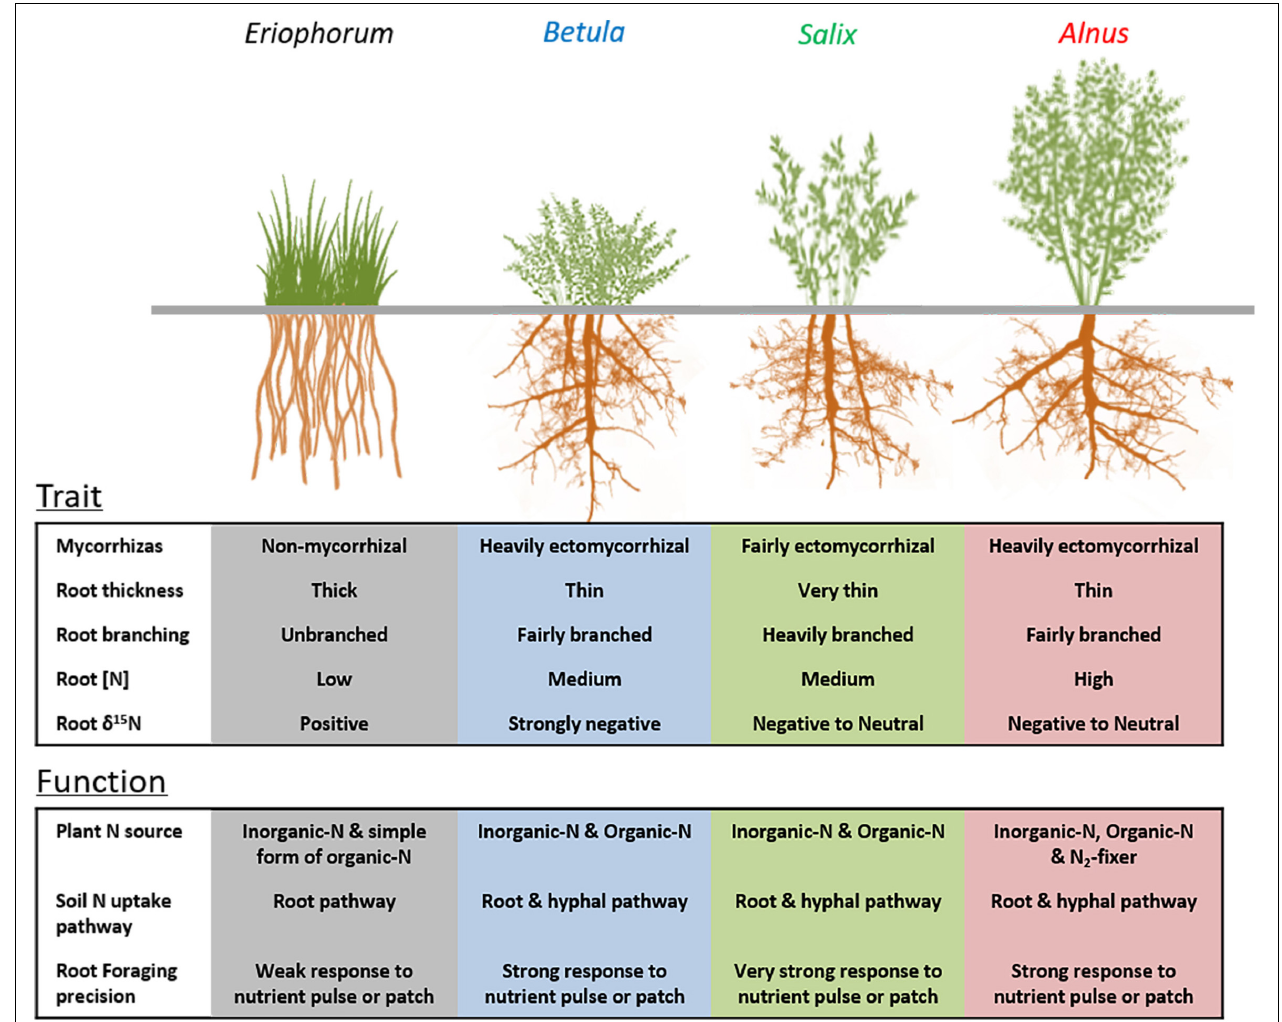
FIGURE 7 | Diagram showing the differences in root traits and functions relevant to nutrient acquisition among arctic tundra shrubs ( Alnus , Salix, and Betula ) and sedges ( Eriophorum vaginatum ). Root functions are predicted by the root traits in this study and trait-function linkages reported in previous